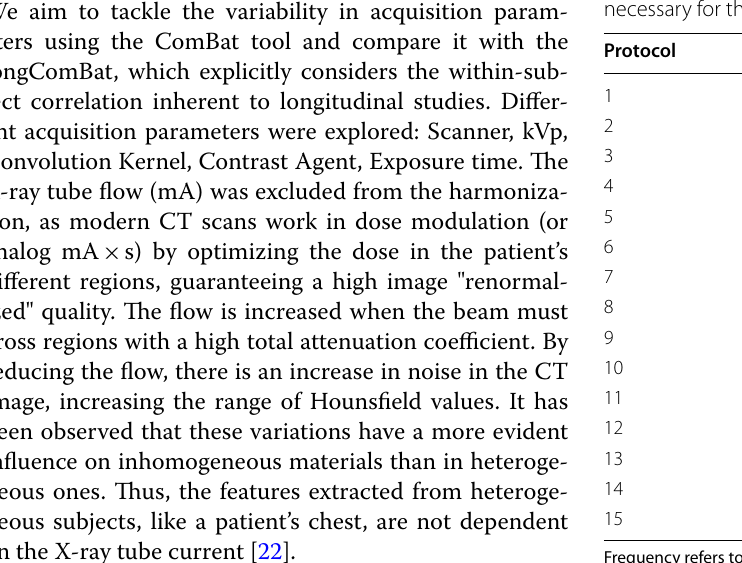
Table 2 Summary of different imaging acquisition protocols